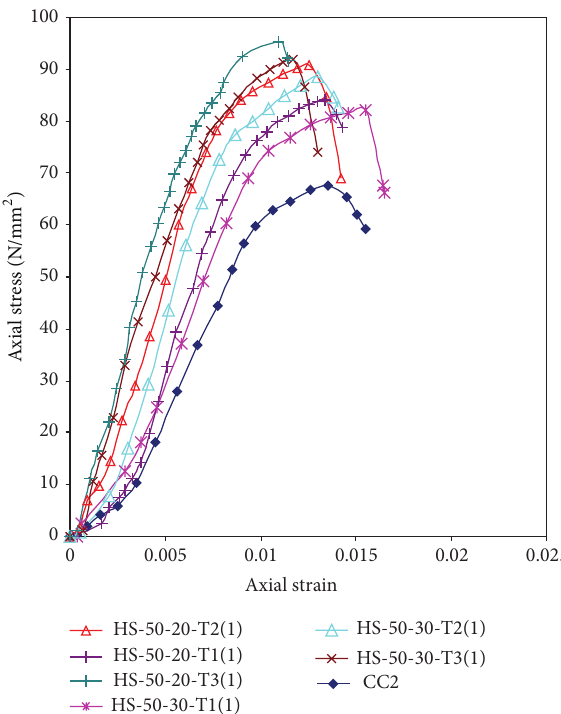
Figure 14: Axial stress-strain behaviours of all columns—comparison.